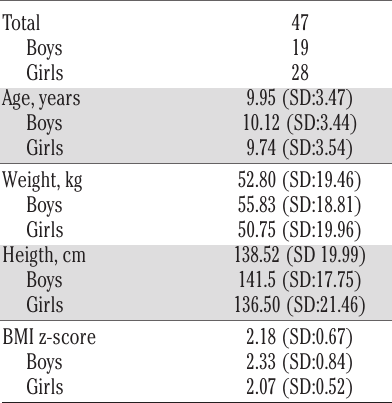
Table 1. Antrophometric parameters, expressed as mean and standard deviation, in both